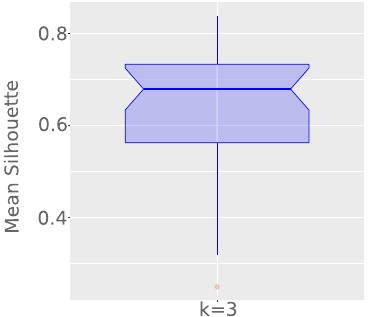
Figure 1. Mean Silhouette variation ( S µ ), considering three groups of countries clustered by the absolute number of confirmed cases per million